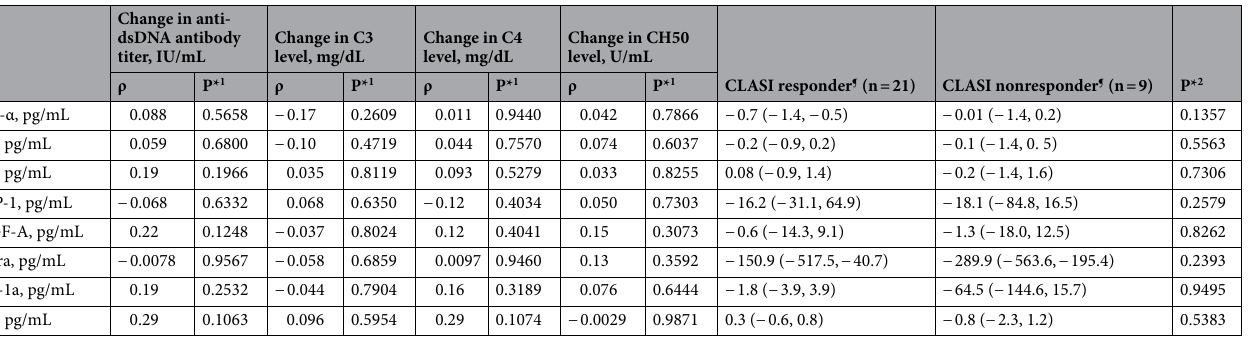
Table 3. Association between clinical parameters and changes in proinflammatory cytokines. The association between the changes in proinflammatory cytokines and changes in anti-dsDNA titer levels and complement levels was analyzed using univariate analysis. ρ indicates Spearman’s correlation coefficient. * 1 p < 0.05, Spearman’s correlation. ¶ Of the patients with skin lesion, 21 cases met the criteria for CLASI responder ( +) and 9 cases did not ( −). The median (25% quantile–75% quantile) of change in each proinflammatory cytokine is shown. * 2 p < 0.05, Wilcoxon rank sum